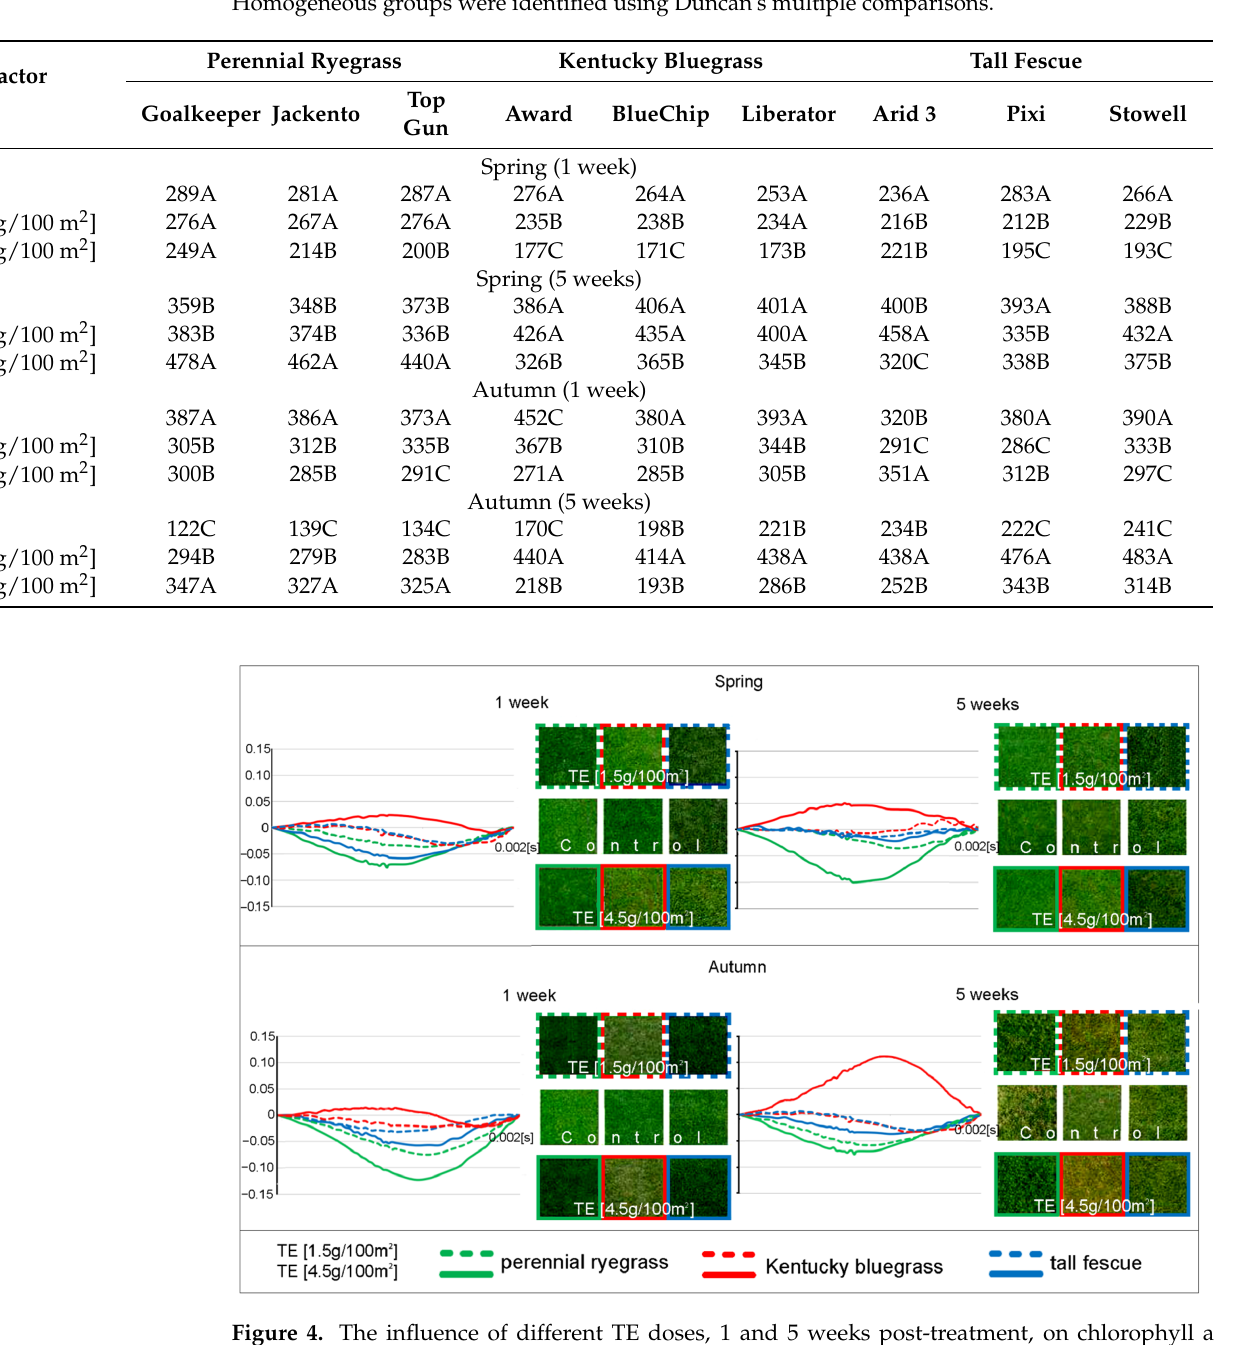
Table 4. Results of TE on Chlorophyll Index measured one and five weeks after TE treatments. Homogeneous groups were identified using Duncan's multiple comparisons.